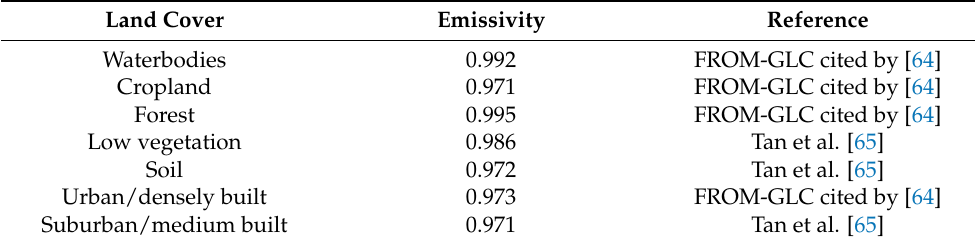
Table 1. Reference values for the LSE model with L8OLI/TIRS band 10. Land